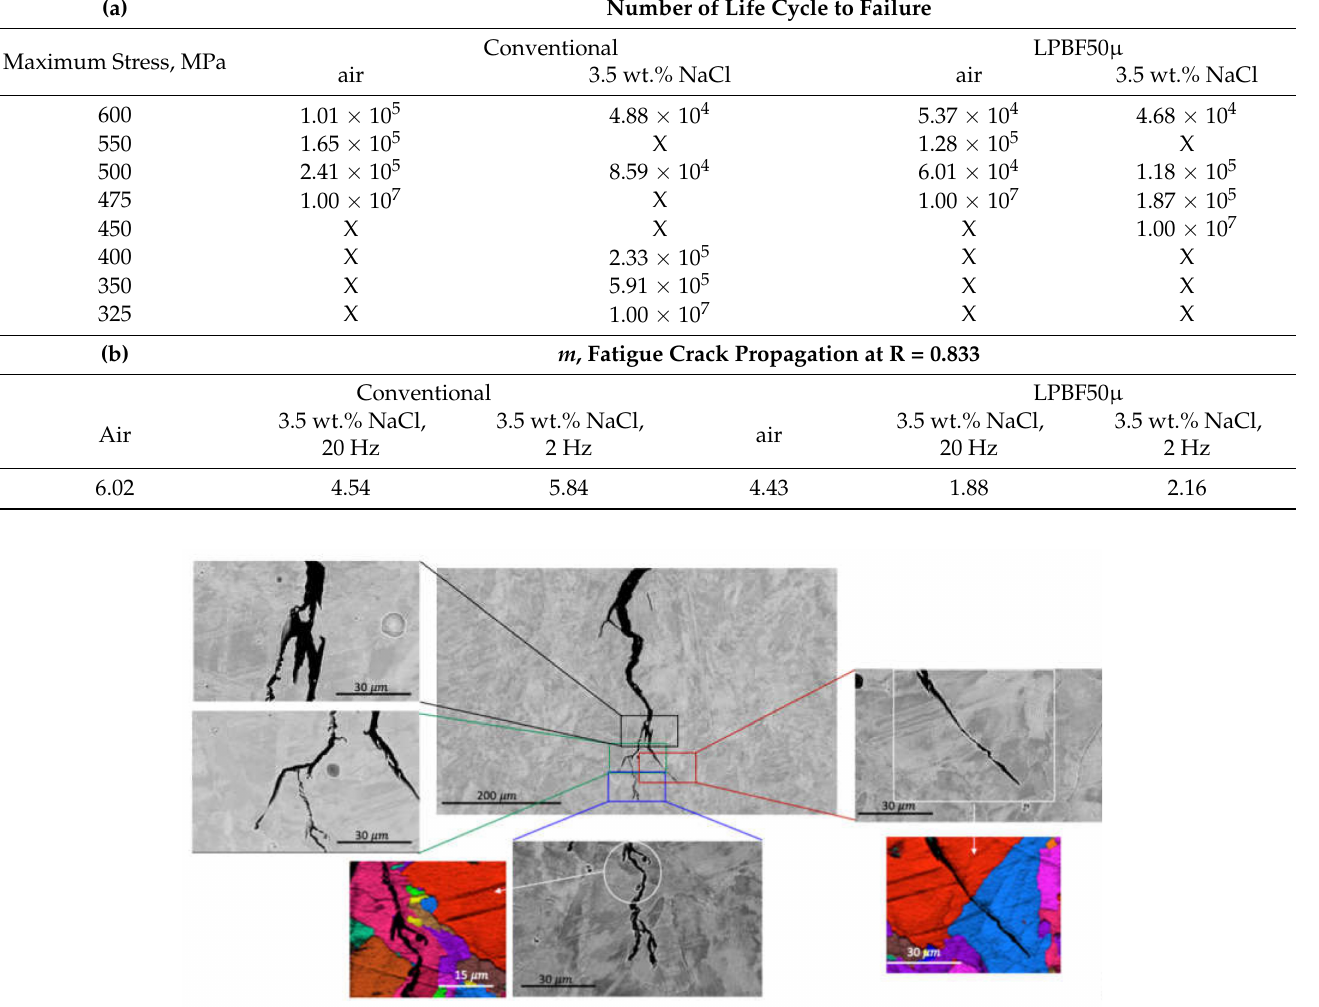
Figure 7. SEM and EBSD images of the fracture morphology showing that the crack predominately propagates in an intragranular manner of the LPBF 316L SS in 3.5 wt.% NaCl